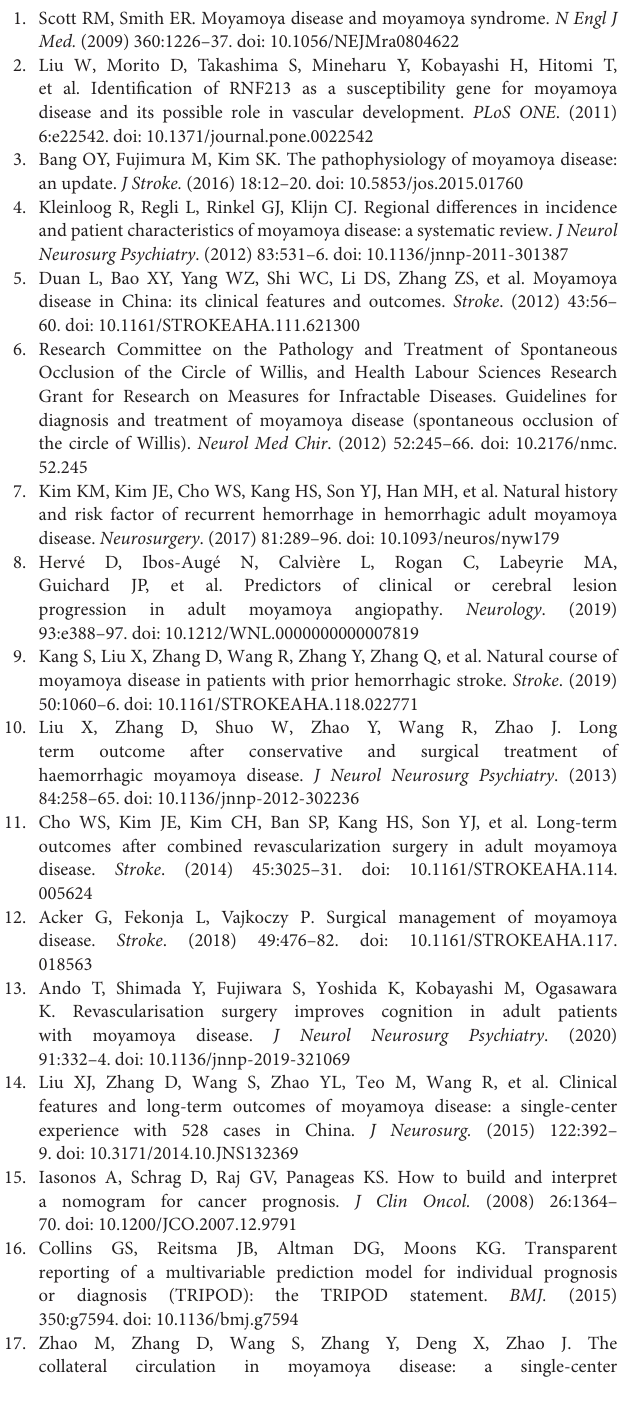
Supplementary Table 4 | The original data of 187 adult patients with ischemic-type moyamoya